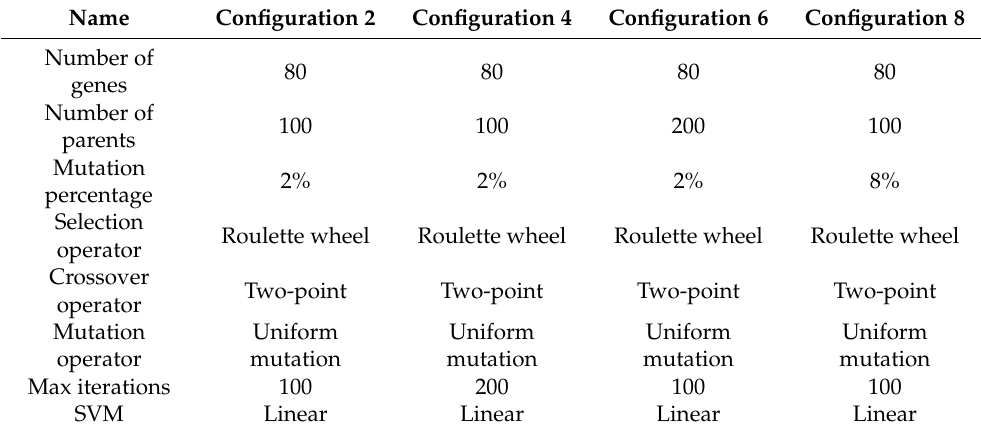
Table 5. Initial parameters used for the genetic algorithms for experiments with Gaussian